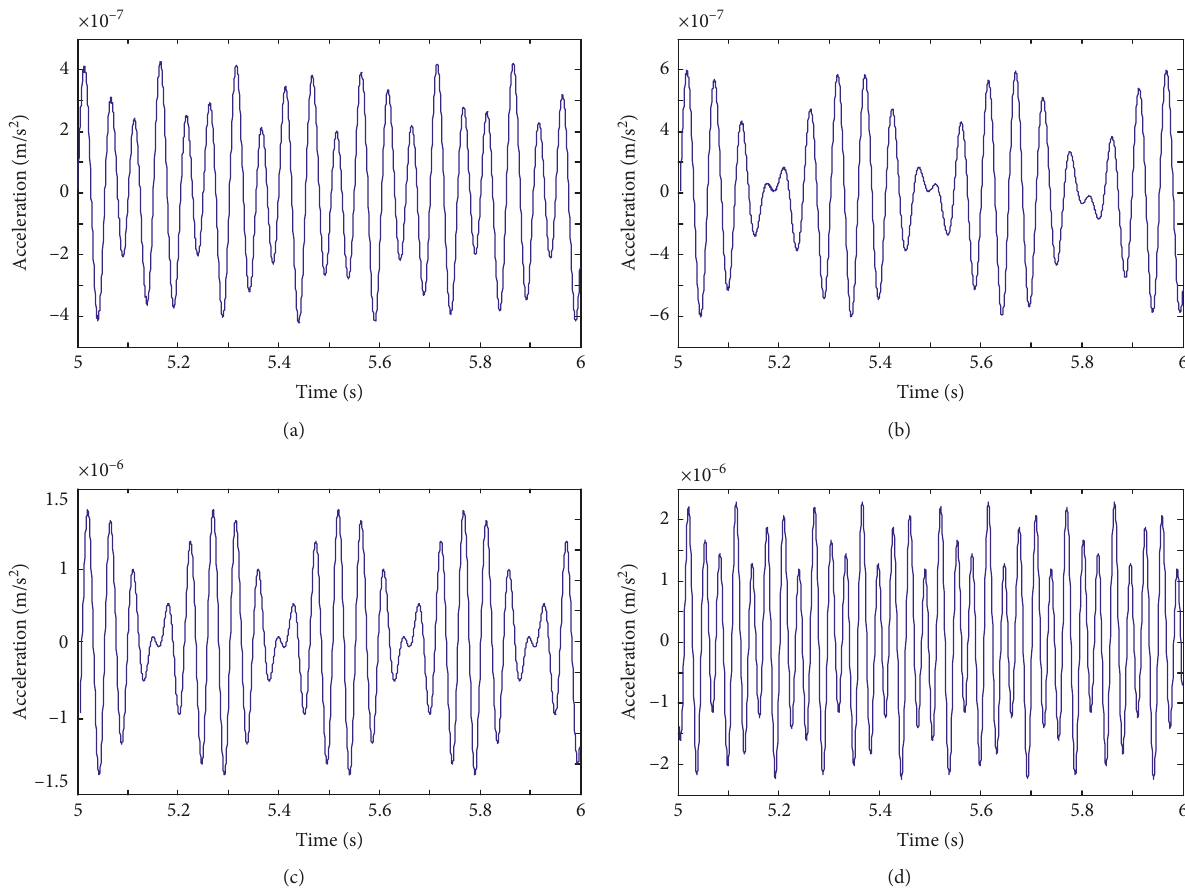
Figure 3: Beat vibration waveforms of middle measurement section on casing at different rotating speeds: (a) ω 125rad/s, ω l 105rad/s, (c) ω h (b) ω h (cid:30) (cid:30)